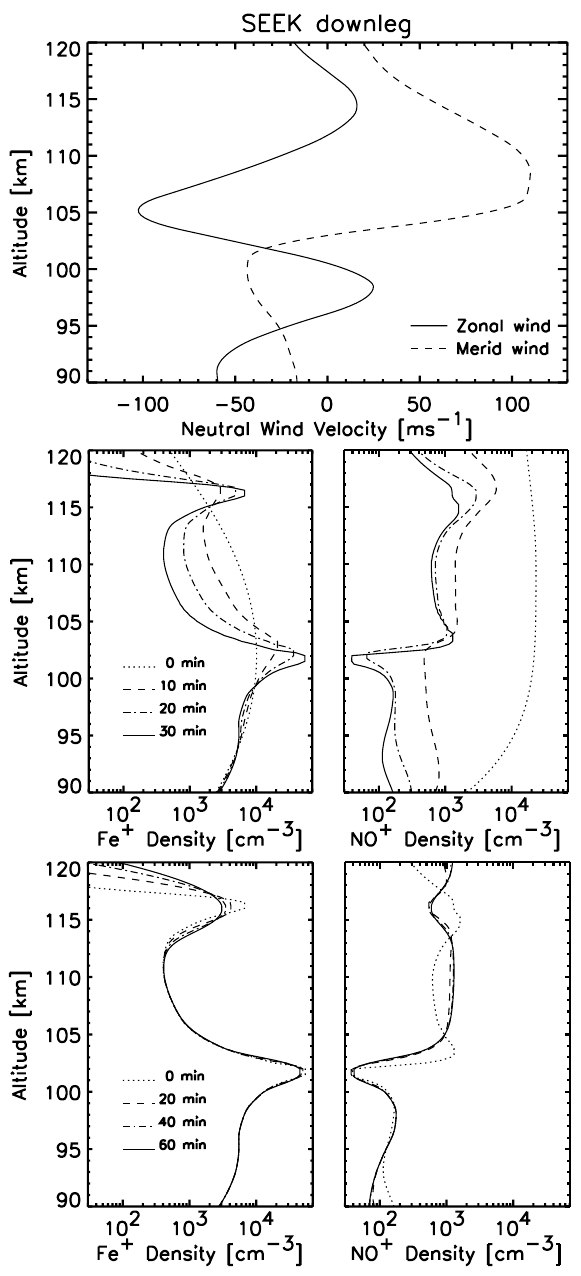
Fig. 1. Neutral wind profiles observed in SEEK which are inter- polated for the simulation grid points (top), plasma density profiles produced by the neutral wind every 10min (middle), and diffusion of the plasma after stopping the neutral wind every 20min